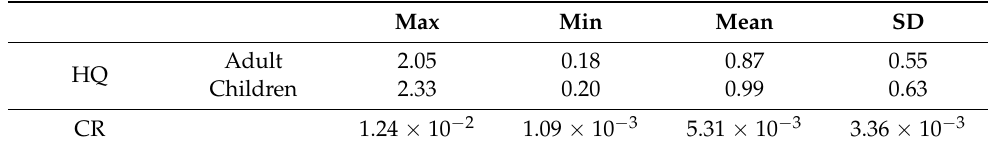
Table 4. Potential health risk of rice grain for local residents.